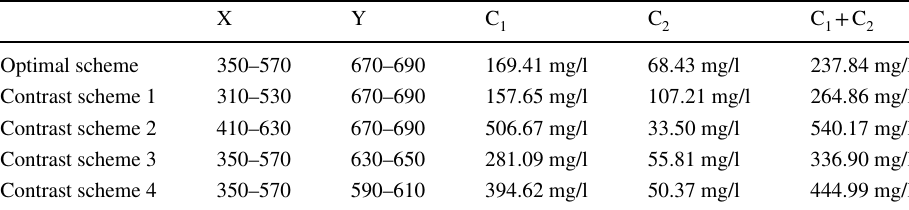
of cutoff wall and chloride concentration in the two water sources